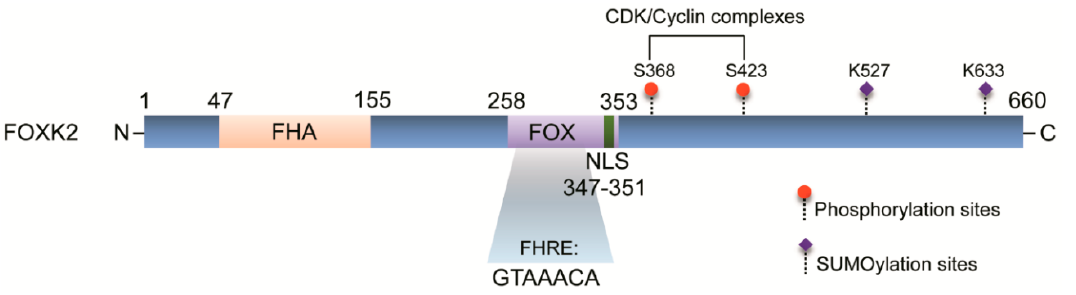
Figure 1. The domain structure of FOXK2 protein. FOXK2 is composed of a forkhead-associated domain (FHA) localized towards the amino terminus and a highly conserved forkhead DNA-binding domain (FOX) localized towards the carboxy-terminal end of the protein. The FOX domain displays a nuclear localization signal (NLS) and mediates FOXK2 binding to consensus sequences with a GTAAACA core motif. The post-translational modifications (PTM) for FOXK2 are shown, where serines (S) are targets for phosphorylation by cyclin-dependent kinases (CDK) and lysines (K), for SUMOylation. Amino-acids sites which are targets for PTM are depicted above the scheme. FHRE, forkhead responsive elements.